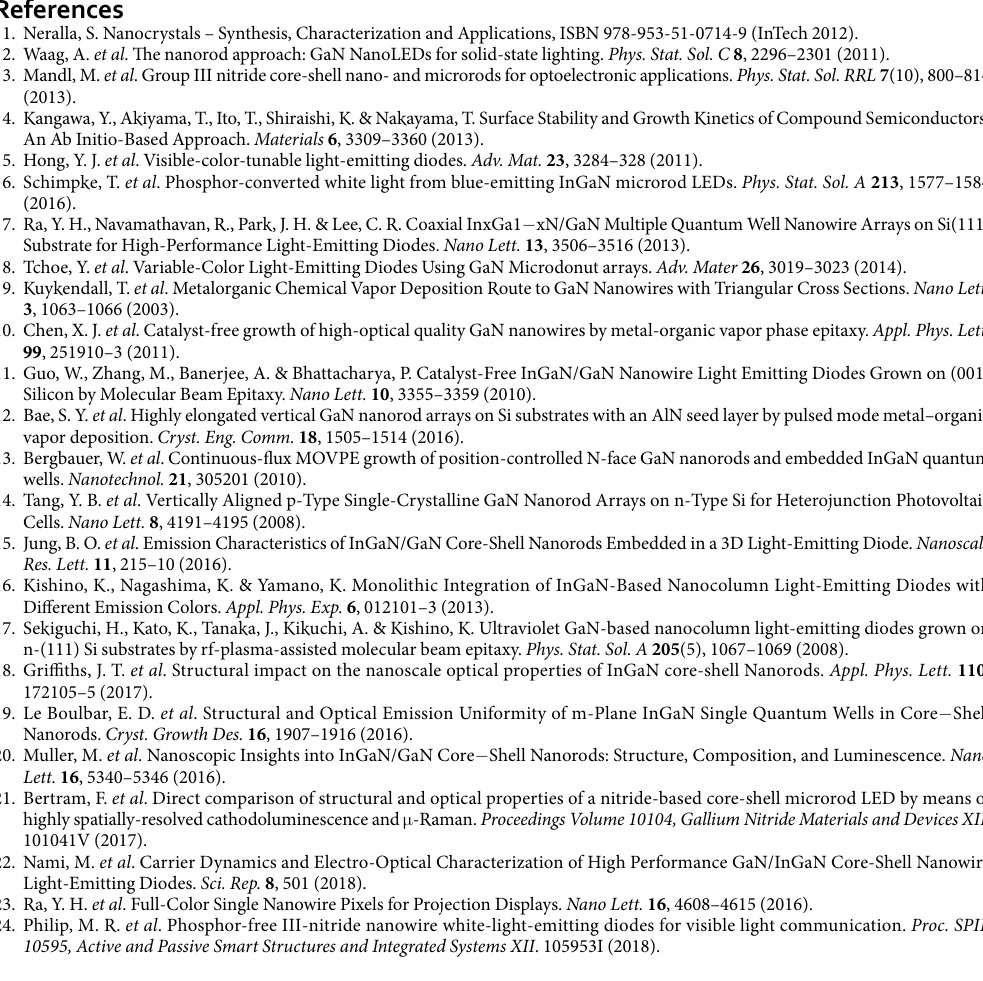
density. This goal can be achieved by developing the pattern for selective area growth, comprising different ele- mentary cells. In general, our findings present a platform for successful implementation of NR arrays with perfect luminescence control for full-color display application.